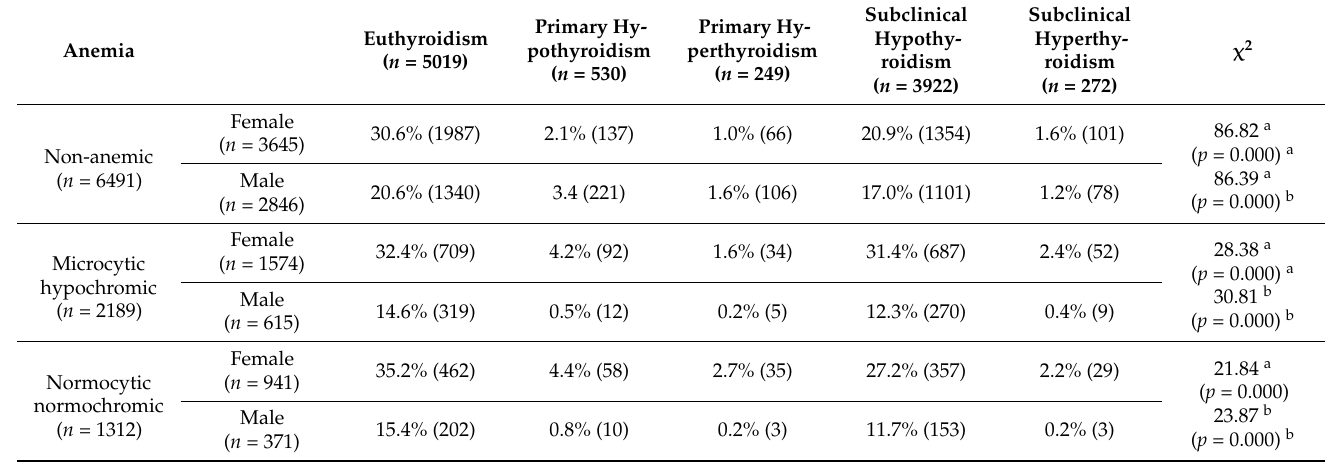
Table 4. Prevalence and types of thyroid dysfunction and anemia.